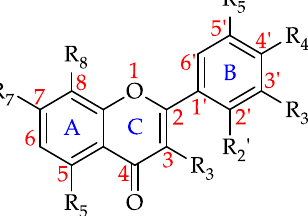
Figure 8. Basic flavonol structure (see 13 – 54 in Table 3). Table 3. Flavonols reported in monofloral honeys (see Figure 8 for general structure).